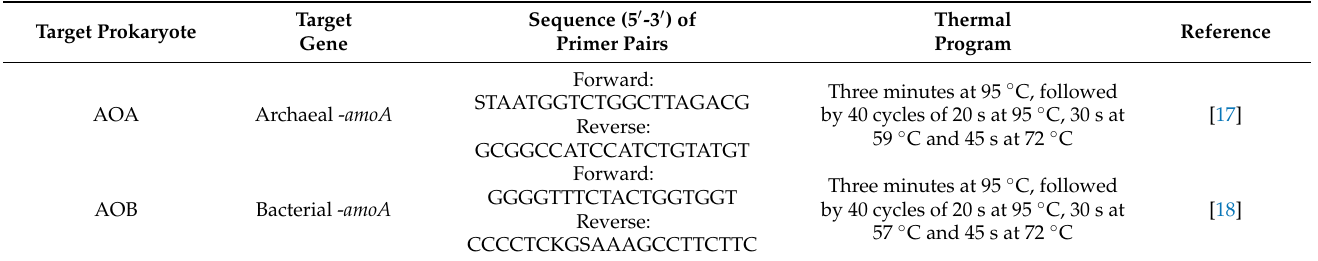
Table 2. Primers and amplification procedures used for qPCR in this study. Target